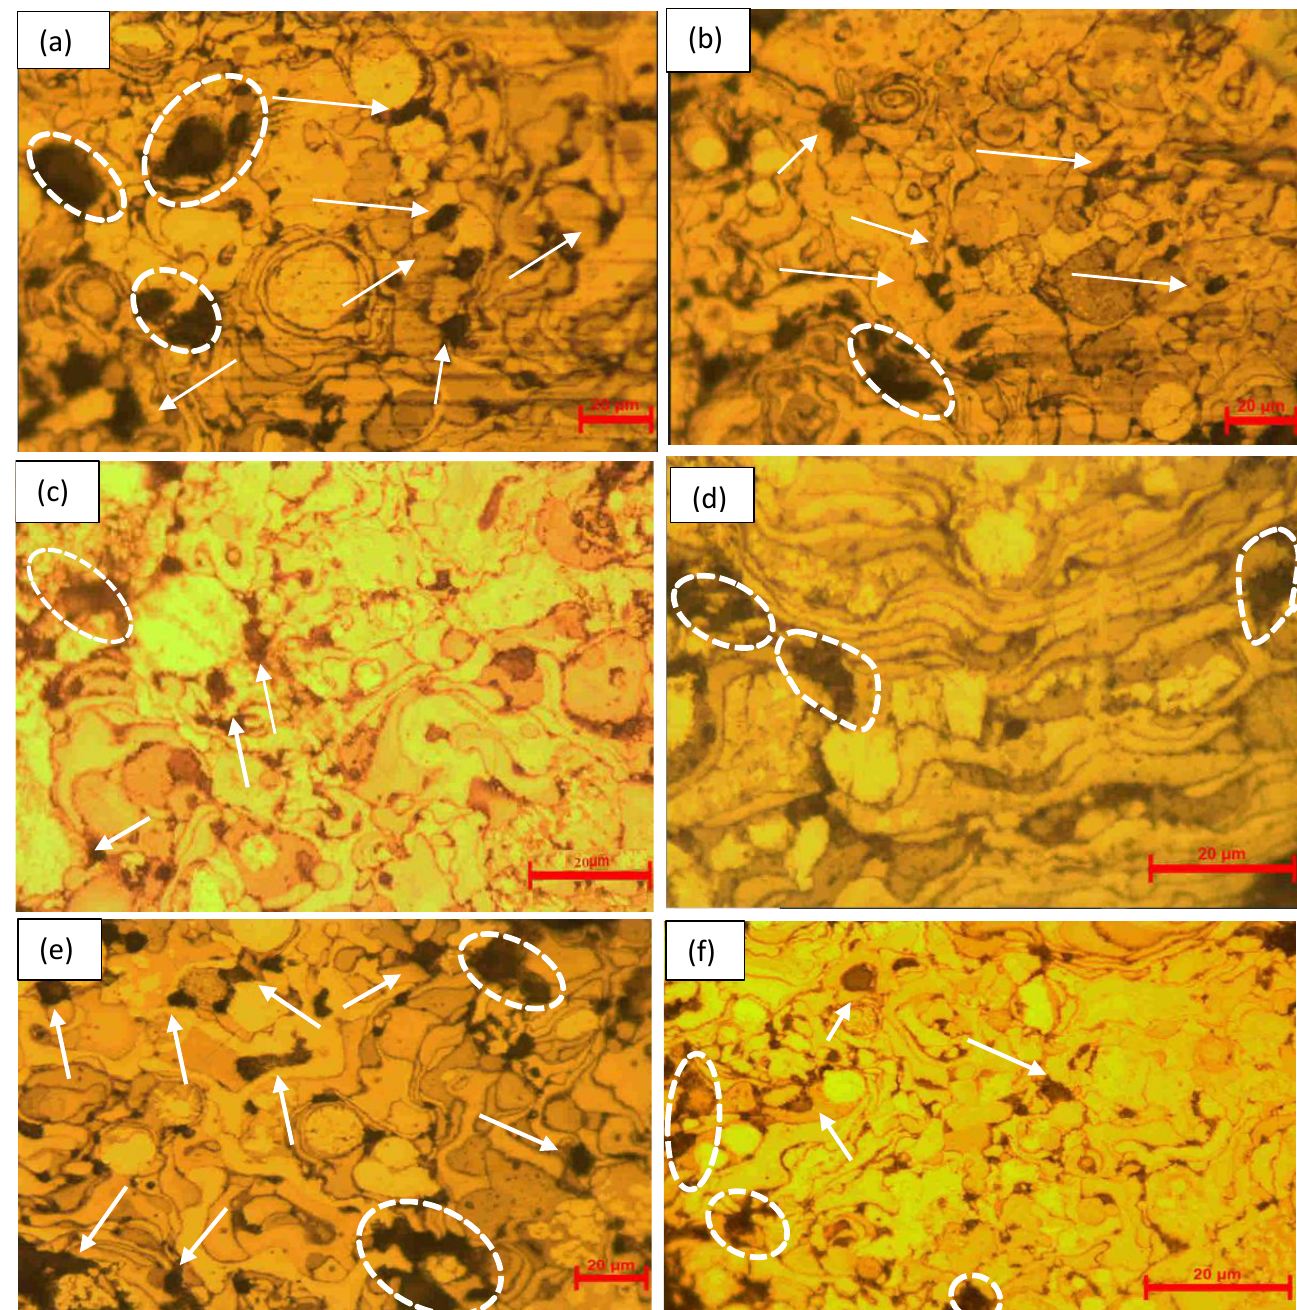
Figure 6. OM of the sample: ( a ) S1, ( b ) S2, ( c ) S3, ( d ) S4, ( e ) S5 and ( f ) S6.